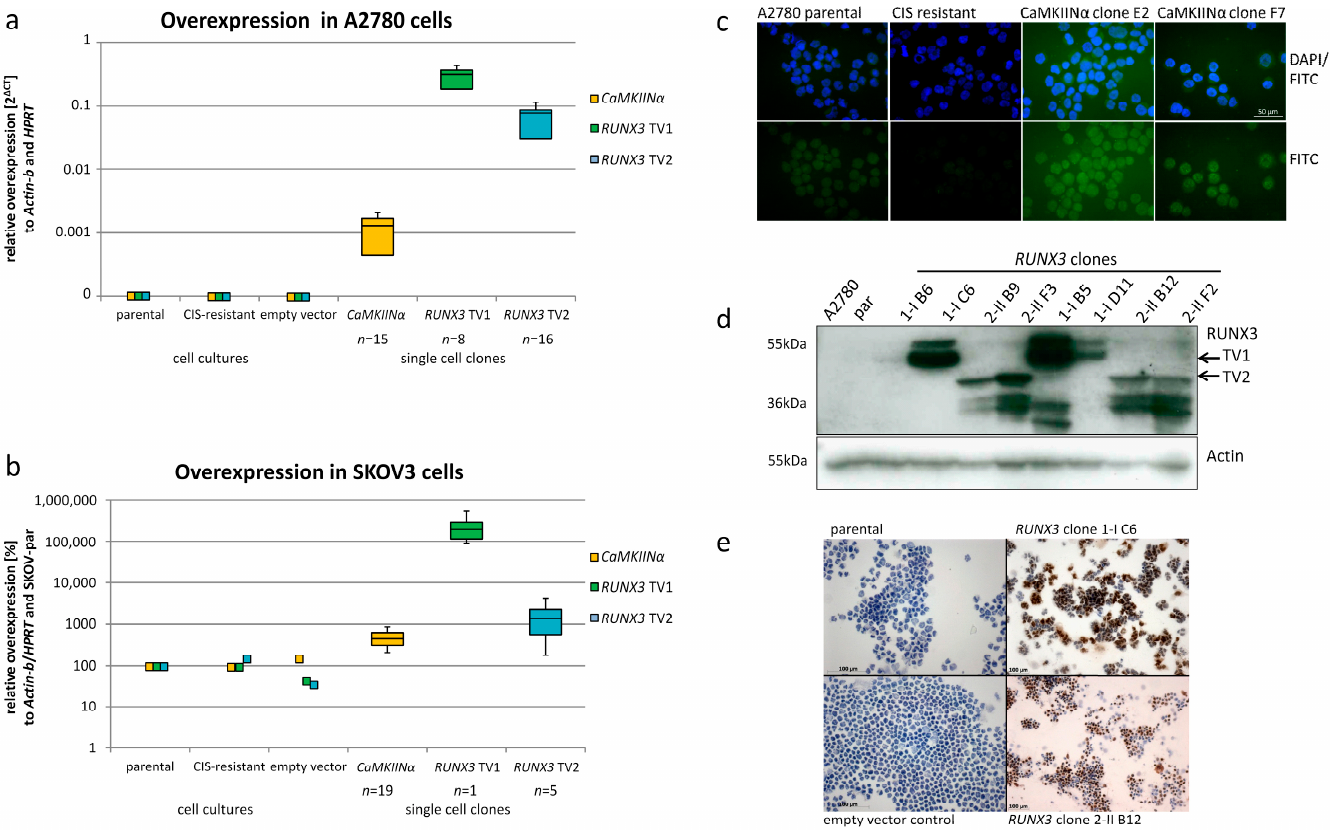
Figure 1. Overexpression of CaMKIIN α and RUNX3 TV1 and TV2 in A2780 and SKOV3 cells. ( a ) Boxplot showing the overexpression of the transgenes in A2780 cells compared to untransfected parental, cisplatin (CIS)-resistant cells and the empty vector controls expressing neither CaMKIIN α nor RUNX3 ; ( b ) Boxplot showing the relative expression of the candidate genes in SKOV3 cells compared to the untransfected parental cells. Whereas CIS-resistant cells and the empty vector controls did not show an increased expression the transfected cells exhibited high levels of the transgenes. All data were normalized against the housekeeping genes Actin-b and HPRT ; ( c ) Immunofluorescence staining for CaMKIIN α exemplary for A2780 validating protein re-expression in transfected resistant A2780 clones (scale bar 50 µ m); ( d , e ) Western blot and immunocytochemistry (scale bar 100 µ m) confirming expression of differently sized RUNX3 isoforms in exemplary single cell clones. (Boxplots depict minimum and maximum values (whiskers); the inter quartile range (box) and the median (line)).